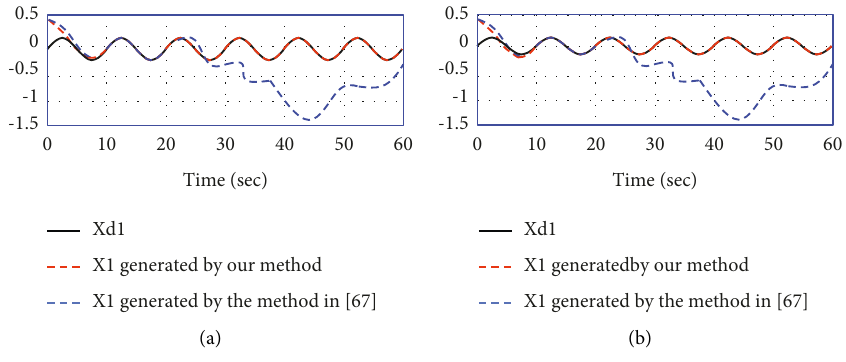
Figure 6: Tracking trajectory of the system.